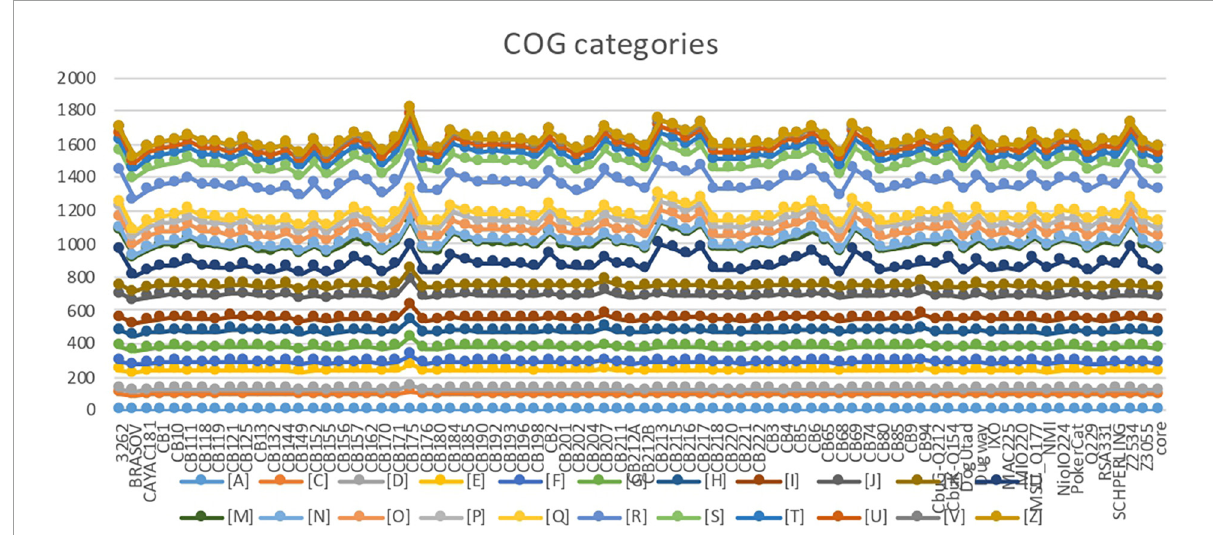
FIGURE2 Distribution of genes into cluster of orthologous groups (COG) categories. J: translation, A: RNA processing and modification, K: transcription, L: Replication, recombination and repair, B: Chromatin structure and dynamics, D: Cell cycle control, mitosis and meiosis, Y: Nuclear structure, V: Defense mechanisms, T: Signal transduction mechanisms, M: Cell wall/membrane biogenesis, N: Cell motility, Z: Cytoskeleton, W: Extracellular structures, U: Intracellular trafficking and secretion, O: Post-translational modification, protein turnover, chaperones, C: Energy production and conversion, G: Carbohydrate transport and metabolism, E: Amino acid transport and metabolism, F: Nucleotide transport and metabolism, H: Coenzyme transport and metabolism, I: Lipid transport and metabolism, P: Inorganic ion transport and metabolism, Q: Secondary metabolites biosynthesis, transport, and catabolism, R: General function prediction only, S: Function unknown.